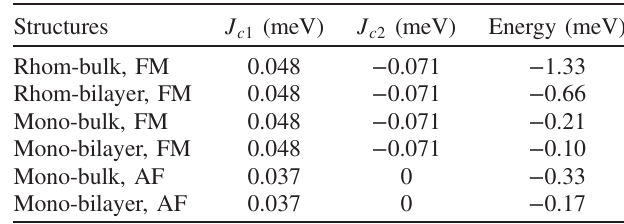
TABLE II. Estimated magnetic bonding energies associated with each Cr 3 þ atom in various crystal structure and exchange couplings [43]. Rhom and mono indicate rhombohedral and monoclinic lattice structures, respectively. In the hypothetical mono-bulk and mono-bilayer cases, the NN and NNN magnetic exchange couplings are assumed to be the same as those of the rhom-bulk and rhom-bilayer, revealing that the FM rhombohedral lattice structure has lower magnetic bonding